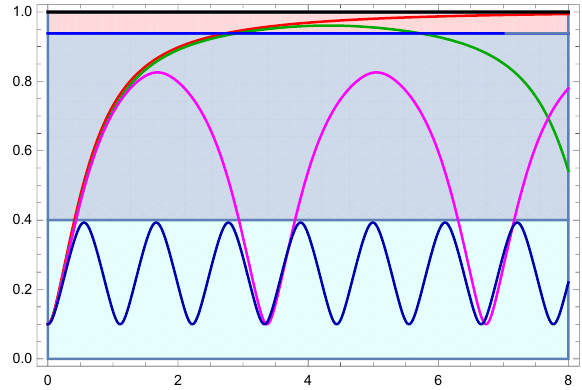
Figure 1 . Three regions of the black hole for the (cid:12)xed chemical potential (cid:22) = 1 : 635 < (cid:22) extr (here (cid:22) extr = 1 : 732 is the value of the chemical potential corresponding to the extremal black hole). The pink region near the horizon z h = 1 is the Rindler region, the middle blue region corresponds to the throat and the cyan one is the outer region. The red curve corresponds to q = 0, the green curve corresponds to q < q ( q is the value of the charge at which the particle starting from the R=T R=T given point, say z (cid:3) = 0 : 1, touches the boundary of the Rindler and the throat regions), the blue one to q = q , the value of the charge at which the particle is restricted to the outer region. The T=O magenta curve corresponds to the particle worldline crossing the blue and the cyan regions and its charge q satis(cid:12)es q < q < q R=T T=O